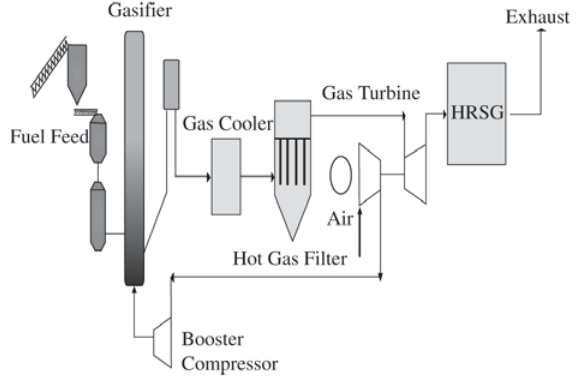
Figure 1. Simplified flowsheet for the hot gas path of the ARBRE project. Figure 2. Flowsheet for the hot gas path of the Varnamo